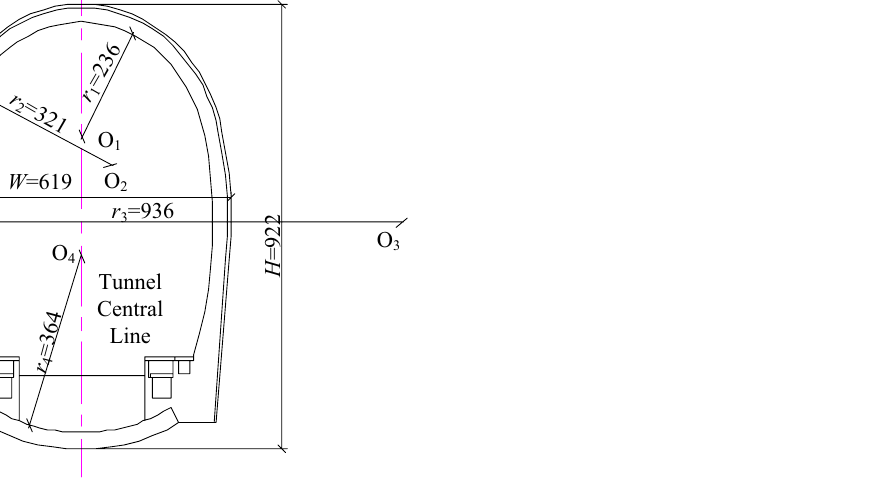
Figure 1. Tunnel cross-section dimensions (units: